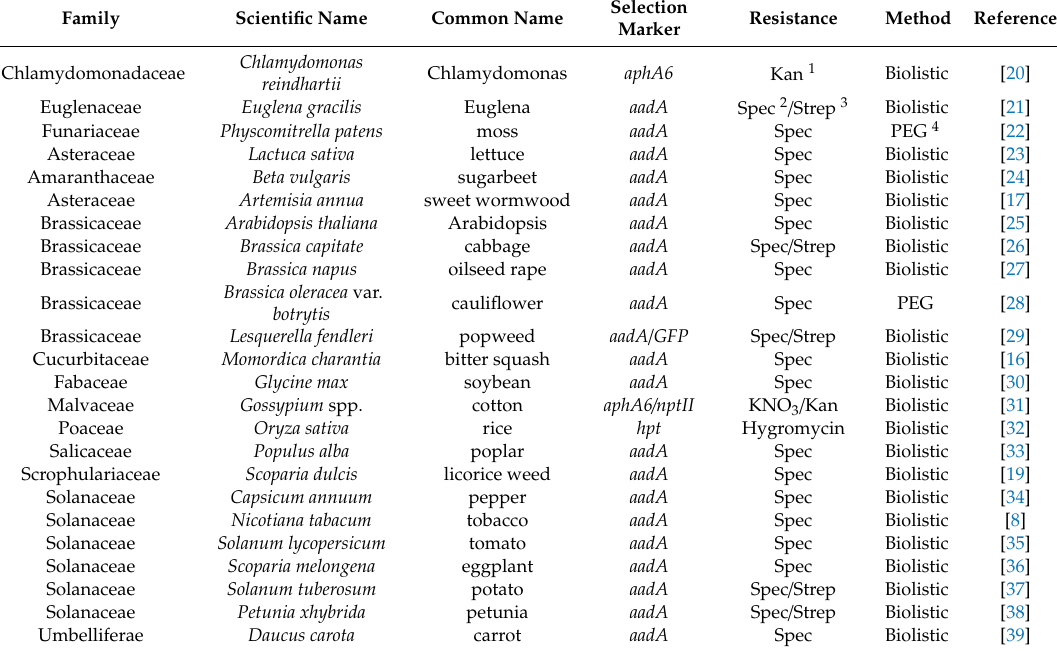
Table 1. Species in which plastid transformation has been